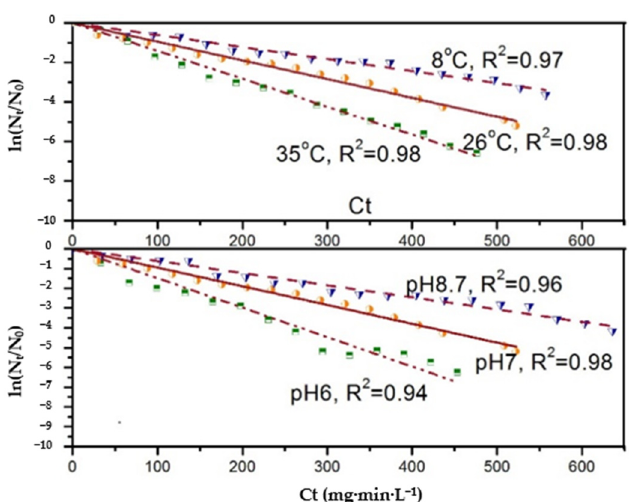
Figure 3. Inactivation on N. europaea applying monochloramine. Experiments were conducted in PBS buffers at temperature varying from 8 ◦ C to 26 ◦ C to 35 ◦ C and pH varying from 6.0 to 8.7. Linear regressions based on the Chick–Watson model were represented as Equation (1) for different pH and temperature conditions. R 2 represents correlation coefficient